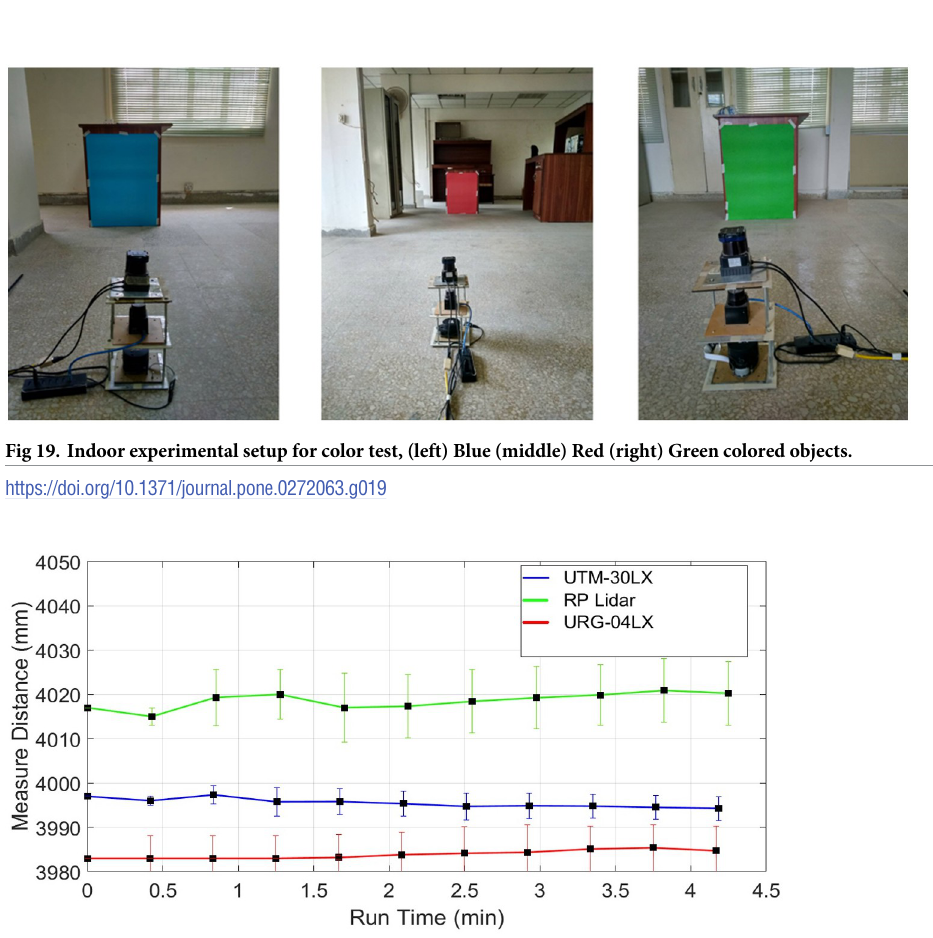
Fig 20. Plot of mean and standard deviations values for red color